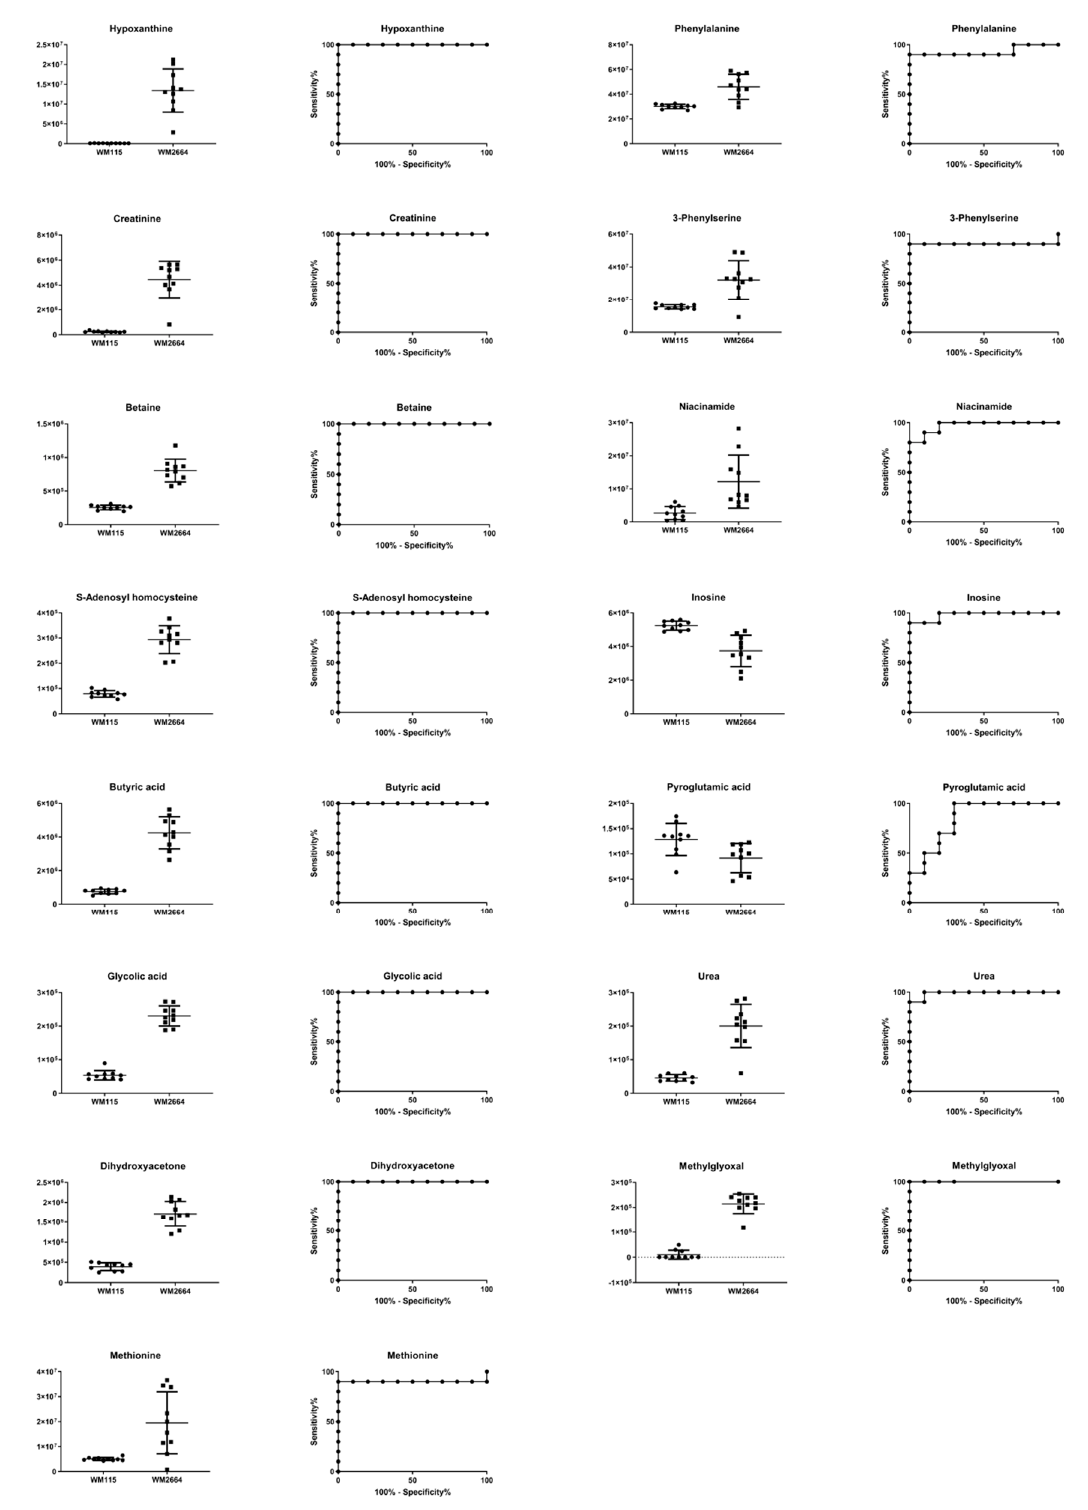
Figure 11. Boxplots and ROC curves, for identified MS features, in positive ion mode, with AUC >